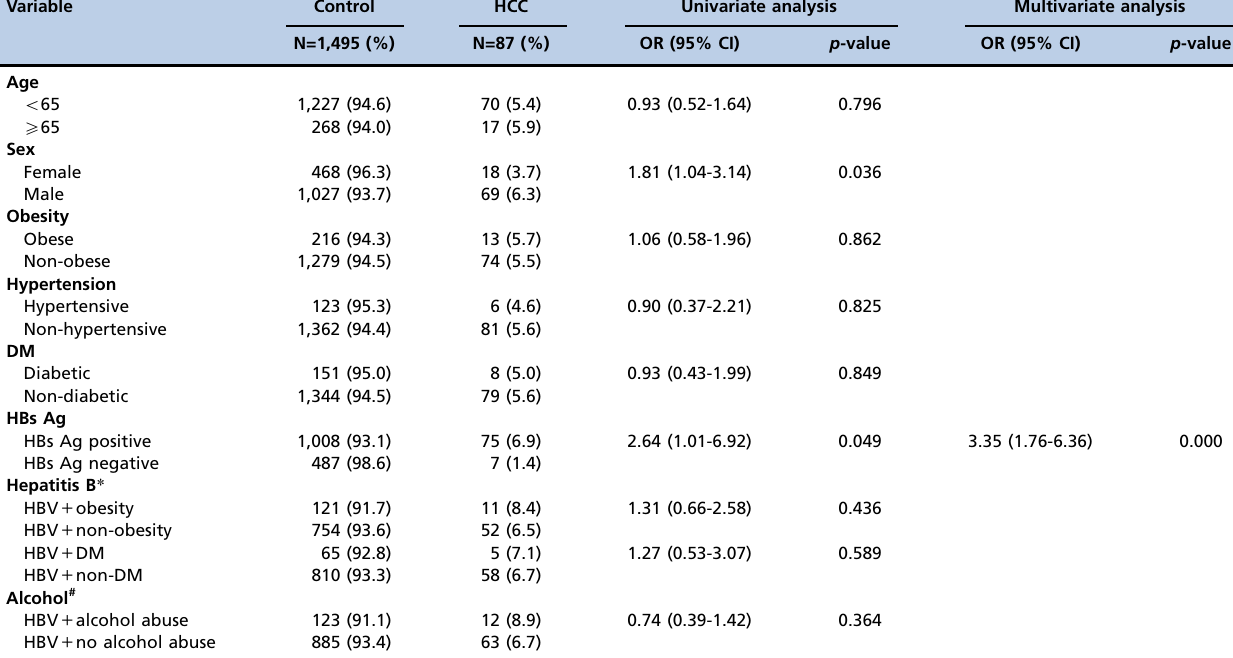
Table 4 - Selected risk factors for HCC. Variable Control HCC Univariate analysis Multivariate